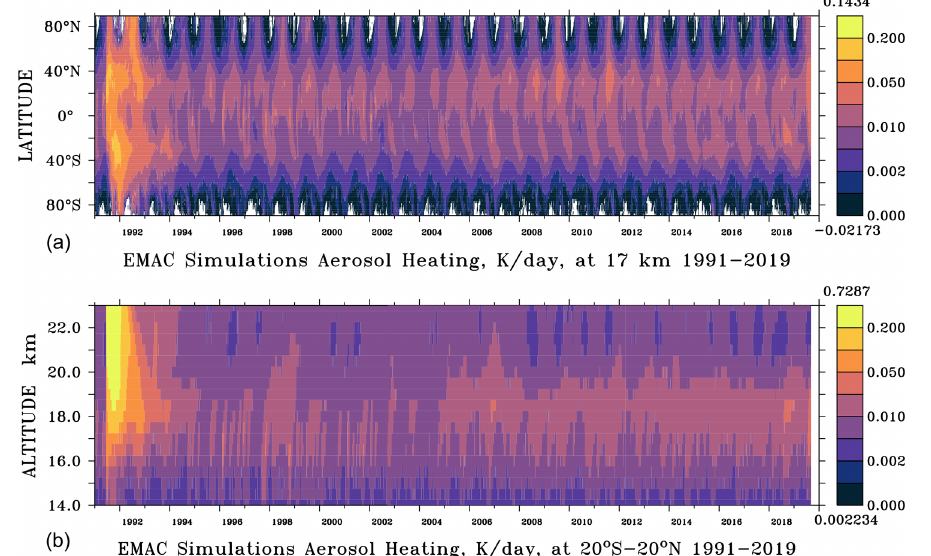
Figure 12. EMAC simulation of the aerosol radiative heating in Kd − 1 for solar and infrared radiation from January 1991 to August 2019 (5d averages) based on the volcanic sulfur emission inventory (Table 2), in horizontal distribution at 17km altitude (a) and in vertical distribution for tropical regions 20 ◦ S–20 ◦ N (b)